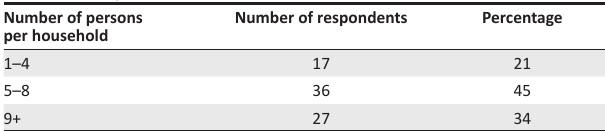
TABLE 2: Family size of the household.